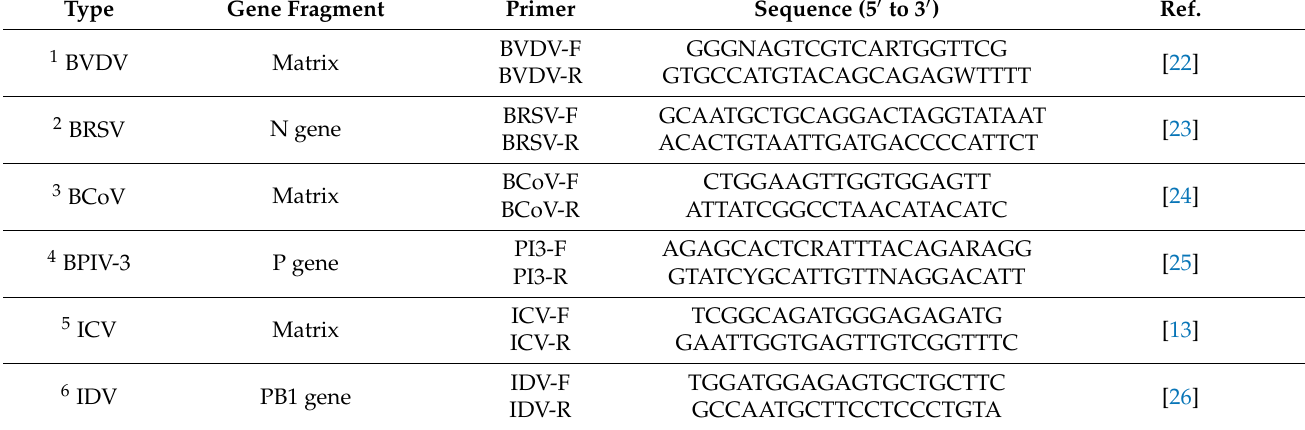
Table 1. Sequences of the primers used to detect viral pathogens in this